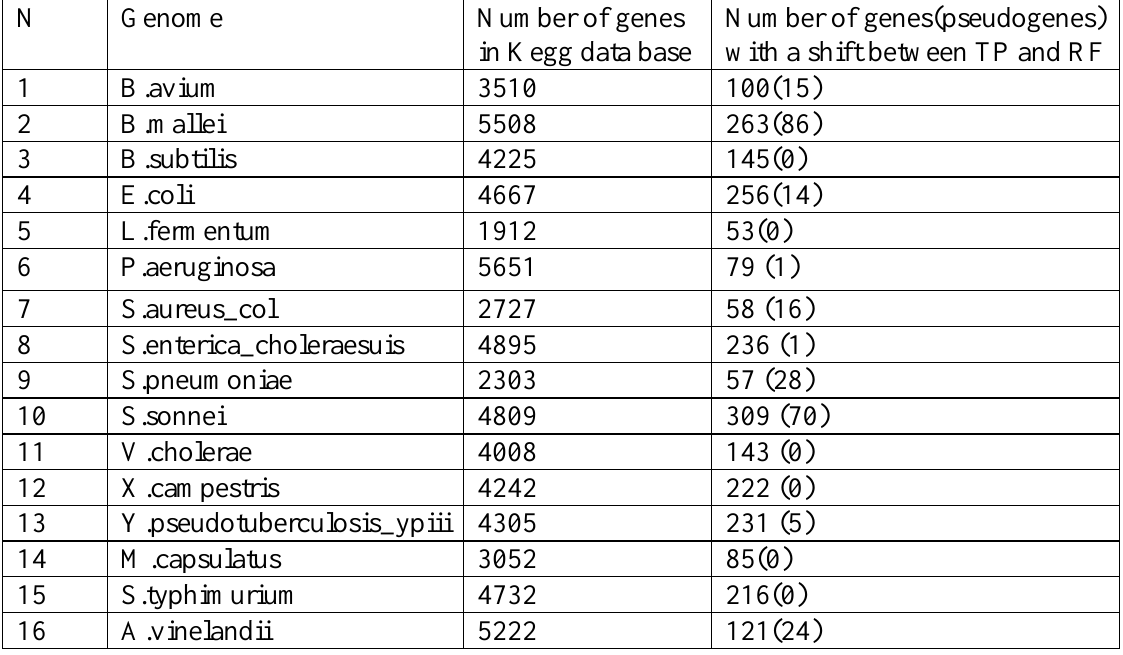
Table 2. Number of genes with a shift between TP and RF in some prokaryotic